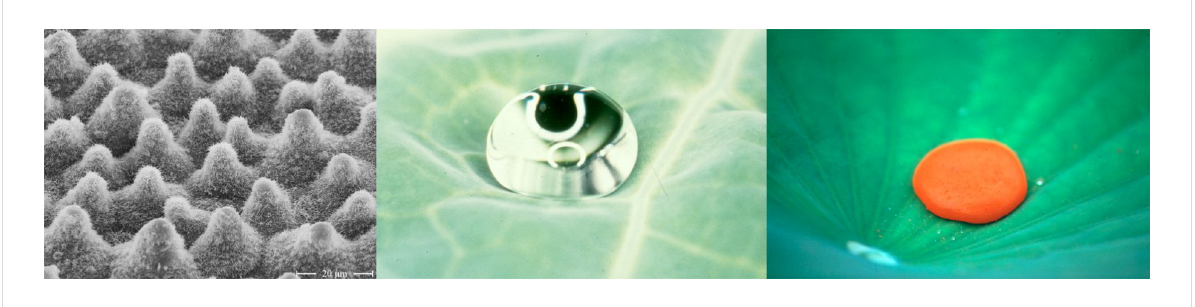
Figure 7: Fundamentals of self-cleaning in plants: a rough, hydrophobic surface (left) causes water to form spheres not adhering to the leaf (middle) removing particles while running off the leaf (right).